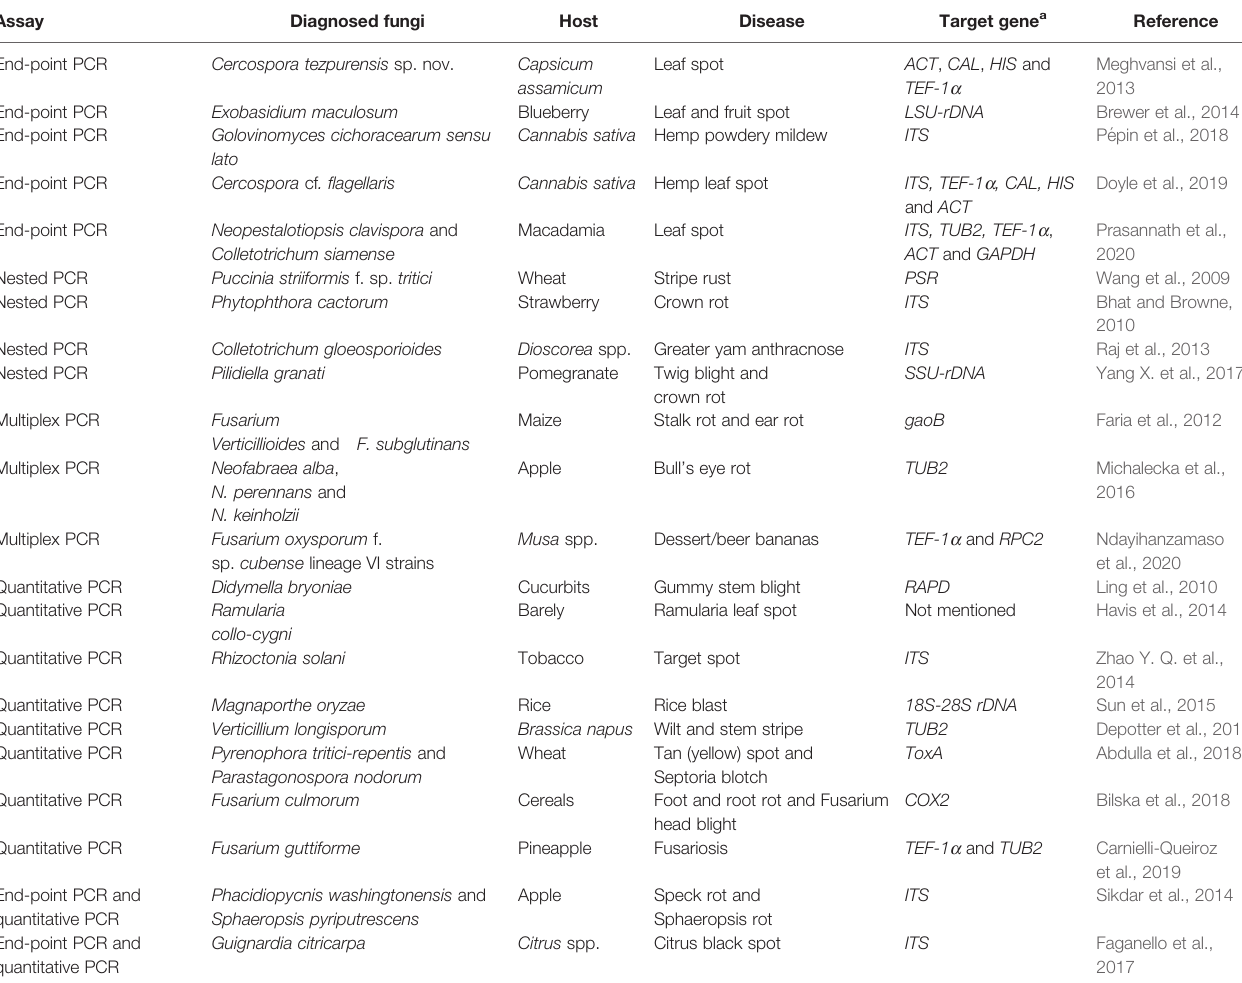
TABLE 1 | PCR based approaches to diagnose pathogenic fungi in different